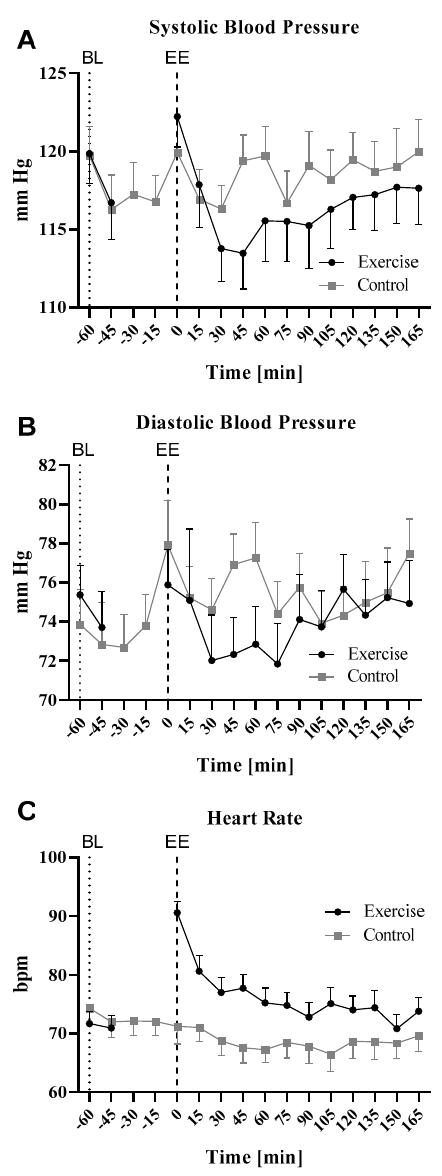
Figure 2. Time course of blood pressure and heart rate during exercise and control intervention, ( A ): Mean systolic blood pressure [mm Hg], ( B ): Mean diastolic blood pressure [mm Hg], ( C ): Heart rate [beats per minute, bpm]. Baseline values (BL) were determined at − 60 min at both study days. Since it was not possible to perform measurements during ergometer cycling, there is a gap in the exercise intervention graph during this period, black: exercise intervention grey: sedentary control intervention; values are expressed as means ± SE, n = 18, EE: end of exercise. Corresponding values are indicated in Supplementary Table S1.